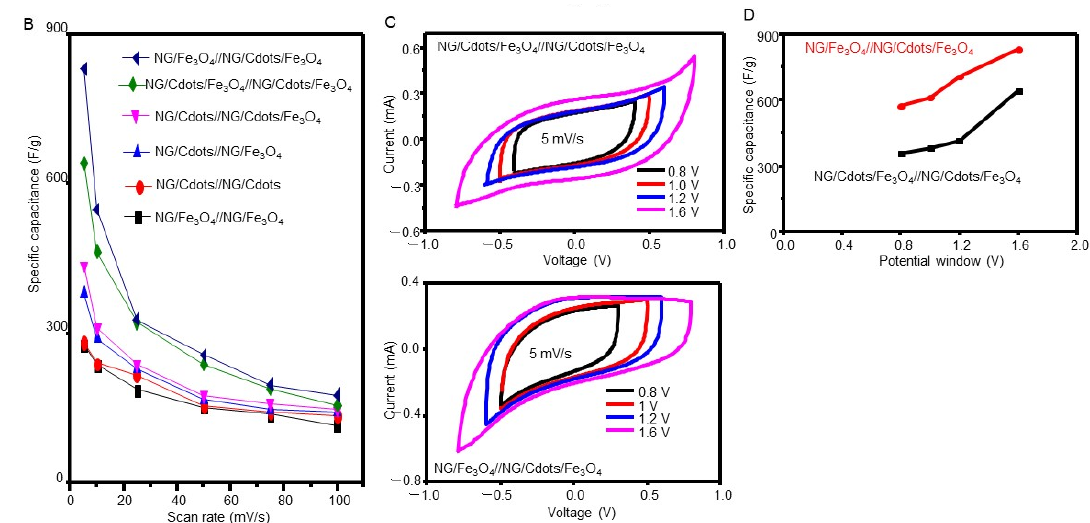
Figure 5. ( A ) CV profiles at different scan rates, ( B ) the specific capacitance as a function of scan rate, ( C ) CV profiles for different potential windows scanned at 5 mV/s and ( D ) the specific capacitance as a function of potential window at 5 mV/s for symmetric and asymmetric supercapacitors.